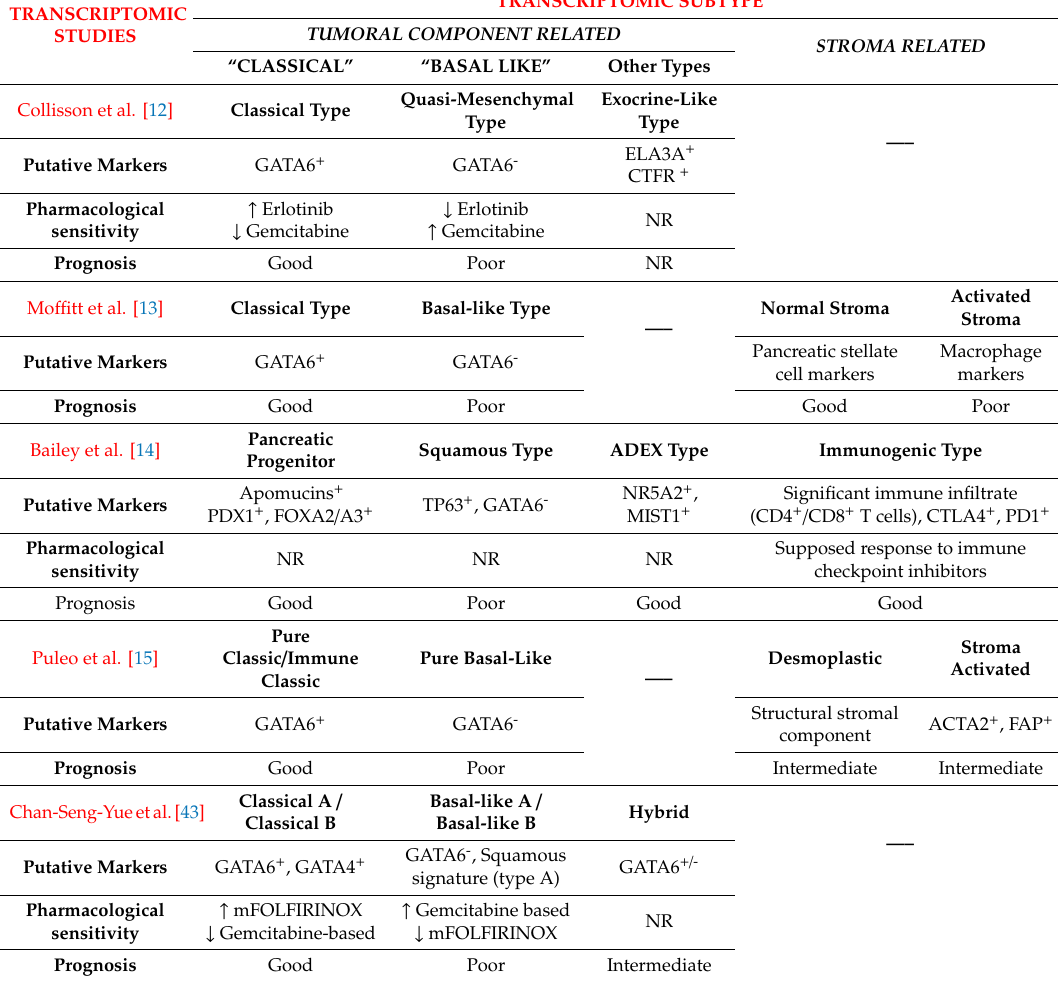
Table 3. Main bulk transcriptomic subtypes of pancreatic cancers. For each identified subtype, informations related to putative cell markers, pharmacological sensitivity (if available) and prognosis are